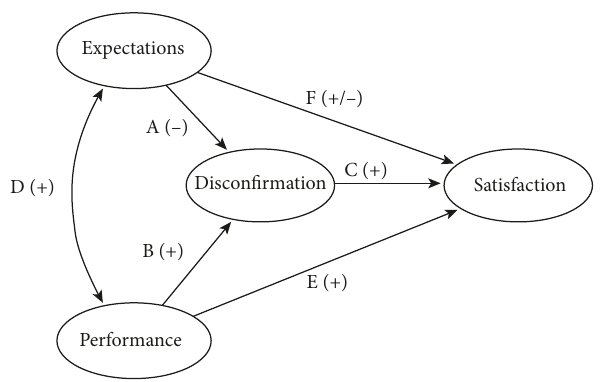
Figure 1: Expectancy disconfirmation model